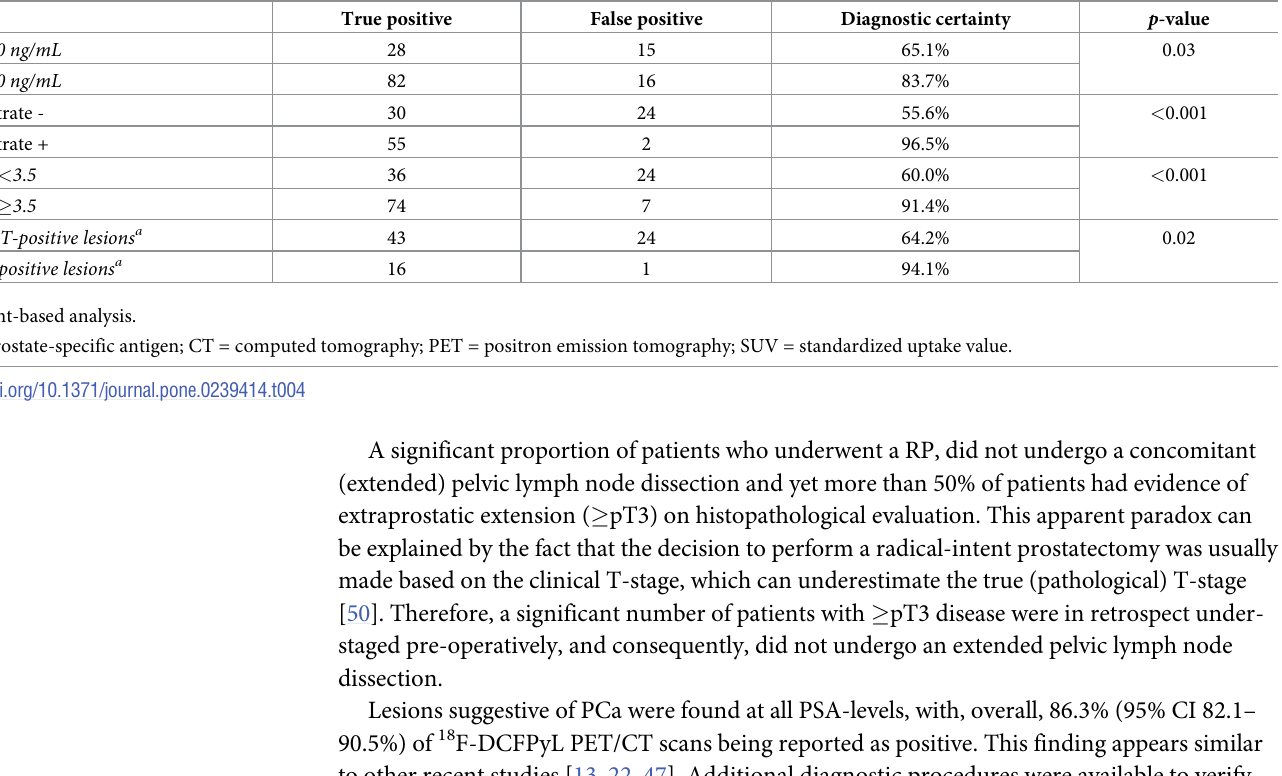
Table 4. Comparison of the diagnostic certainty, stratified per clinical predictor.